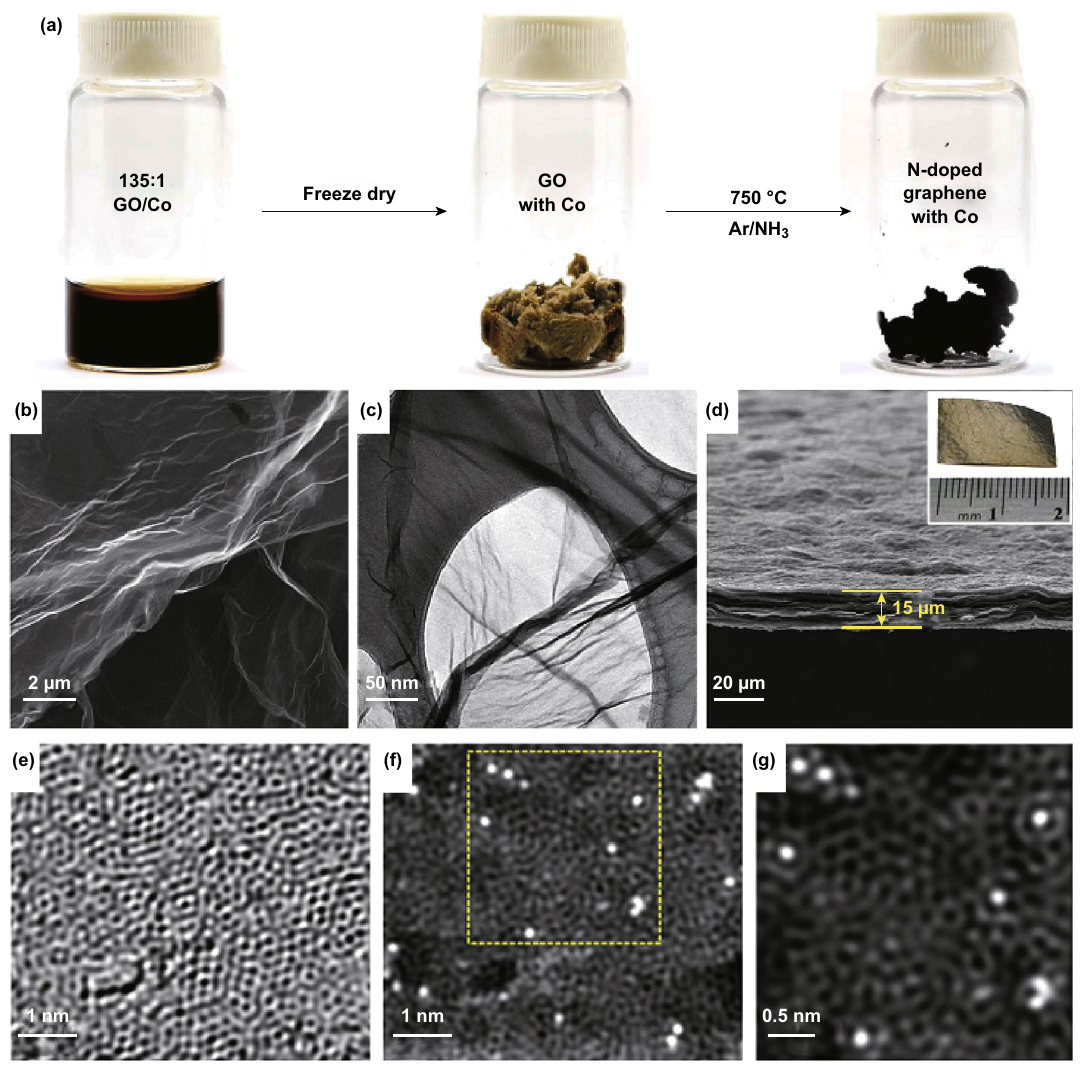
Fig. 8 a The synthetic procedure of the Co–NG material. b SEM, c TEM and d cross-sectional SEM image of Co–NG nanosheets. e Bright- field aberration-corrected STEM image of the Co–NG. f HAADF-STEM image of the Co–NG. g The enlarged view of the selected area in f . Panels are reproduced from Ref. [94] with permission. Copyright 2015 Nature Publishing